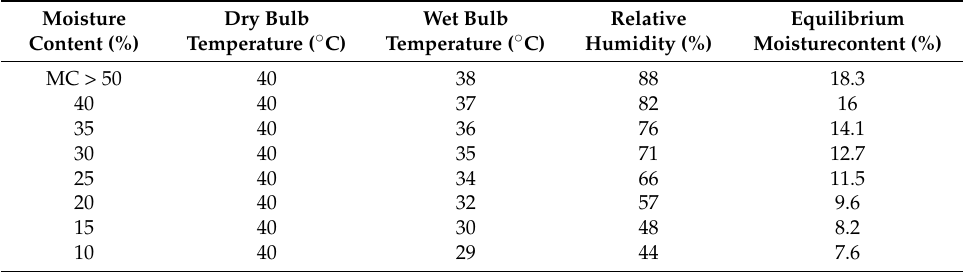
Table 1. Drying schedule for white birch